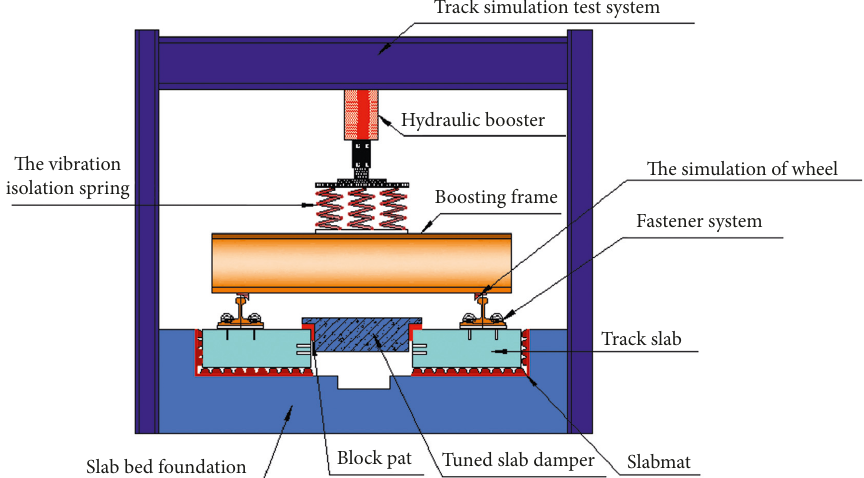
Figure 10: Installment of the testing system.